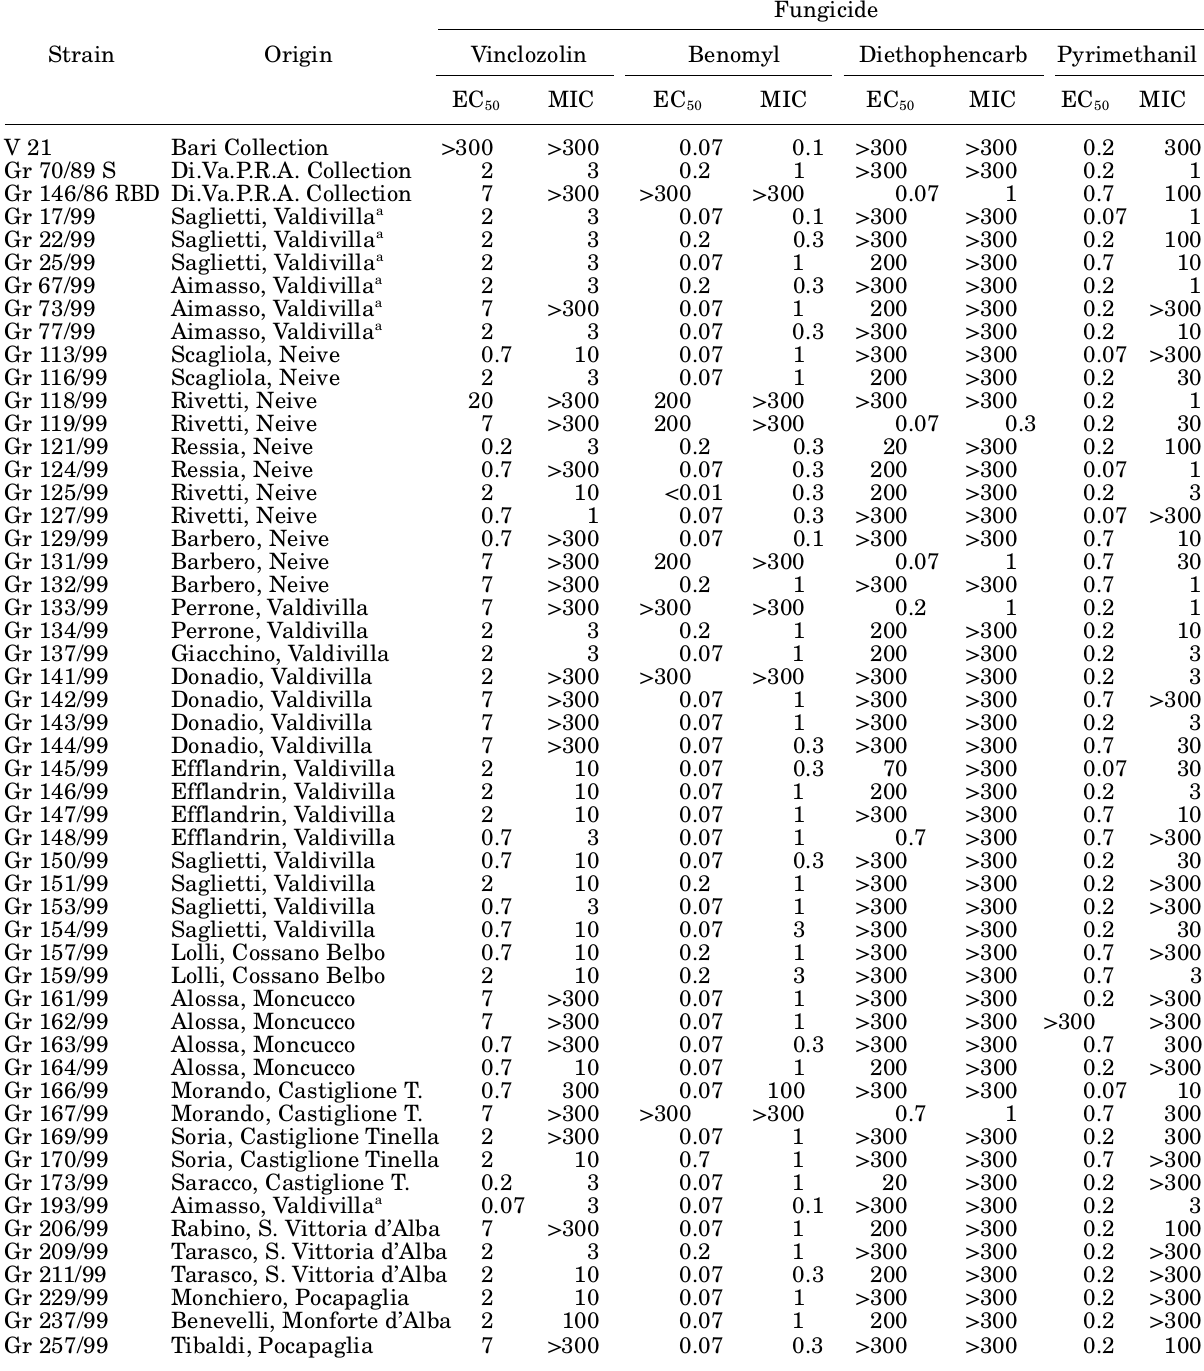
Table 6. Efficacy of botryticides of different classes against isolates of Botrytis cinerea isolated from Italian vine- yards in 1999. Results are expressed as Effective Concentration 50 (EC (MIC) in